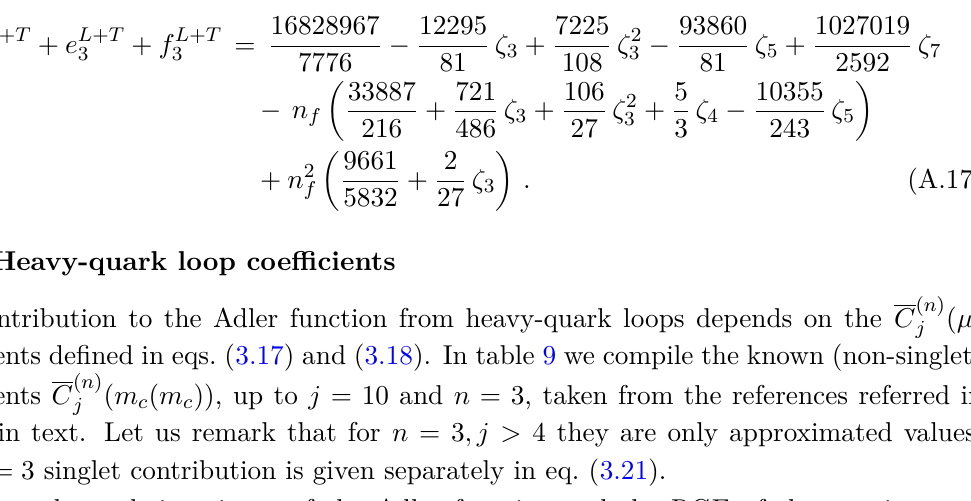
( m c ( m c )) . The values given for C (3) j